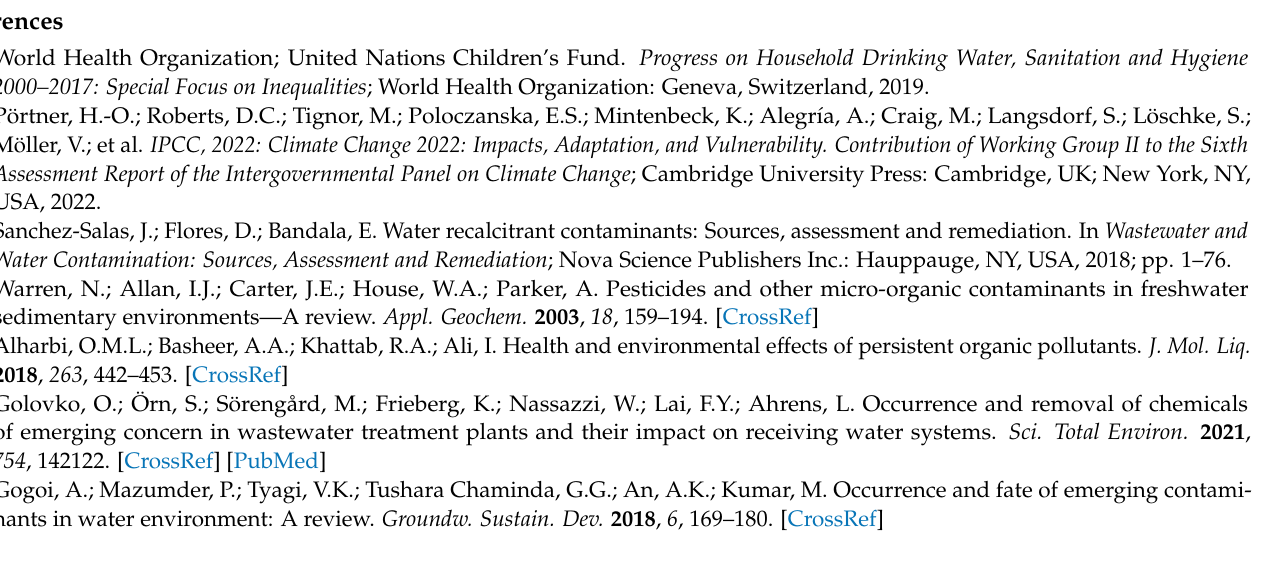
ZC; Figure S5: Degradation profiles of Phenol, Carbamazepine, Tolyltriazole, Ofloxacin obtained using ZCC, ZC, ZnO and reference P25 photocatalyst; Figure S6: Photocatalysts recyclability test on phenol degradation; Figure S7: The degradation percentage of CECs obtain using ZCC, ZC and ZnO photocatalysts after one hour of irradiation in the presence of scavengers t-Butyl alcohol and p-Benzoquinone of hydroxyl and superoxide radicals respectively; Figure S8: Integrated intensities of the EPR spectra as a function of irradiation time of the DMPO/OH · adduct produced by irradi- ation of an aqueous suspension of the samples ZnO, ZC and ZCC samples with UV visible light ( λ > 360